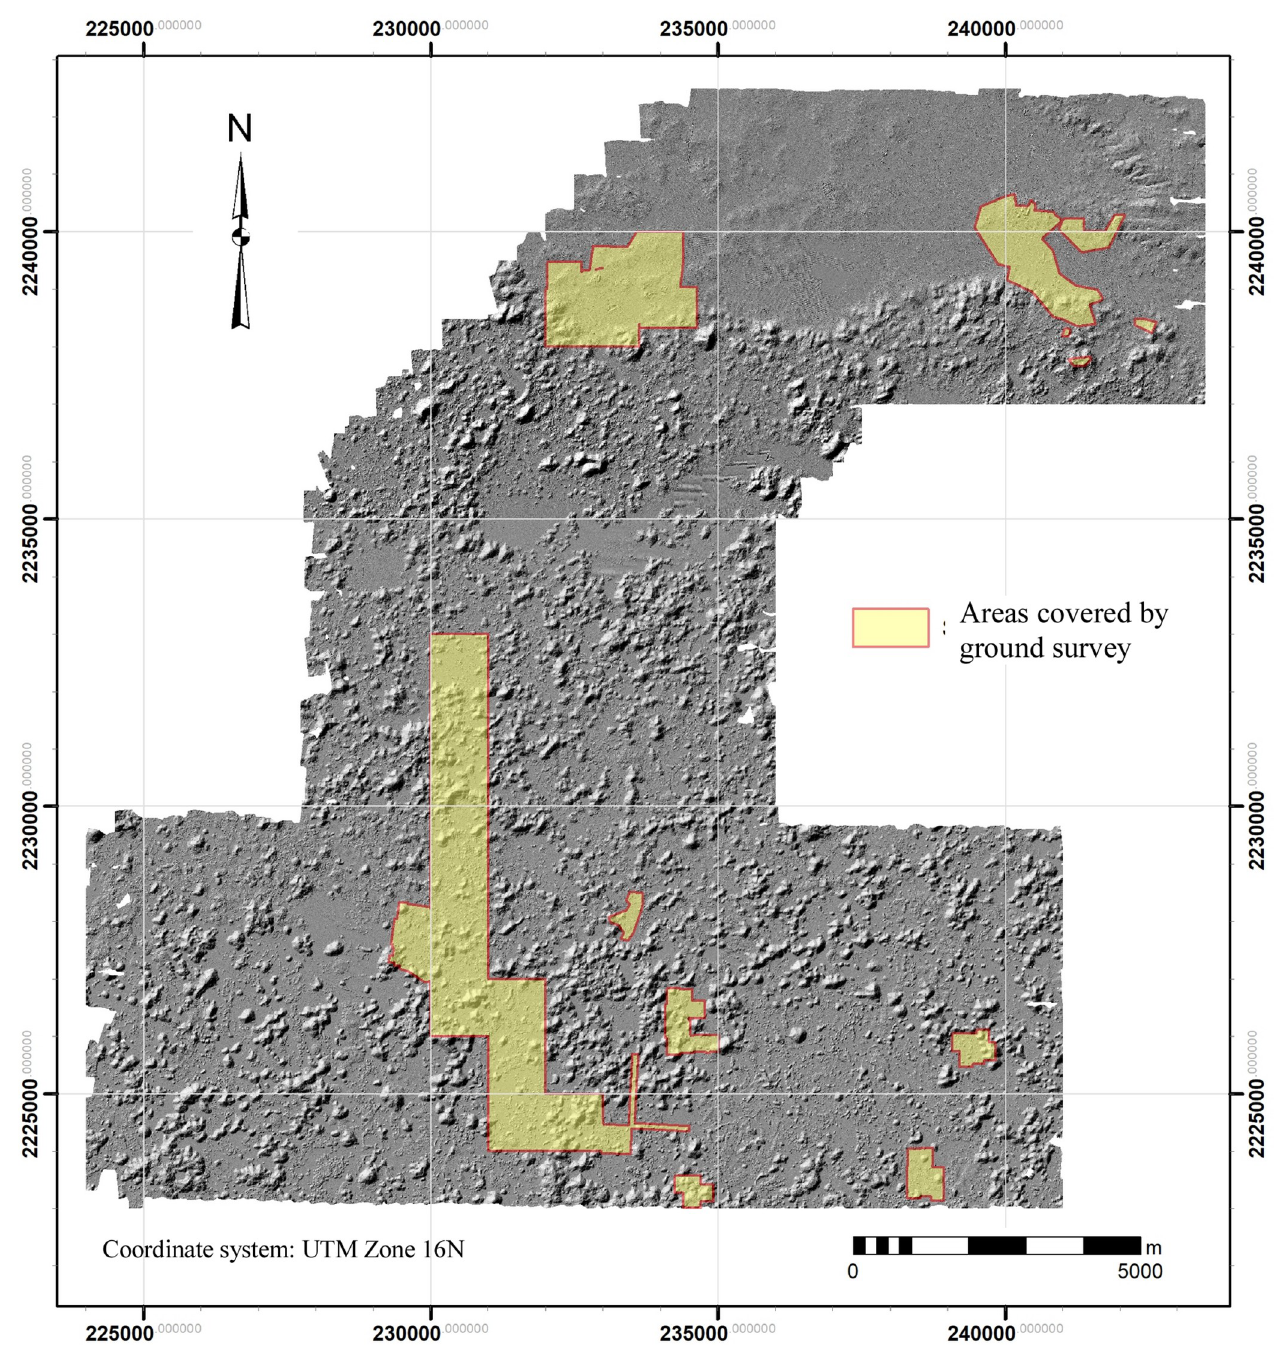
During ground survey of this area, a total of 1781 structures of all types were registered: 524 basal platforms, 1021 perishable and masonry buildings, 46 annular structures, and 190 sec- ondary platforms. Thus, approximately 80% (418 of 524) of the basal platforms could be seen in the lidar, while 106 (20%) could not. Of the 106 that were not identified, 81 (76%)